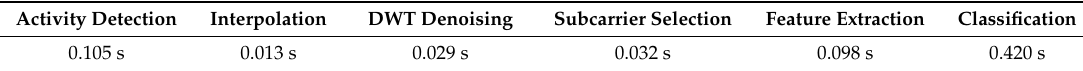
Figure 13. Comparison of the impact of CSI processing modules under the two validation methods. ( a ) 10-fold cross validation. ( b ) Leave-one-subject-out validation. Table 1. Processing time for one